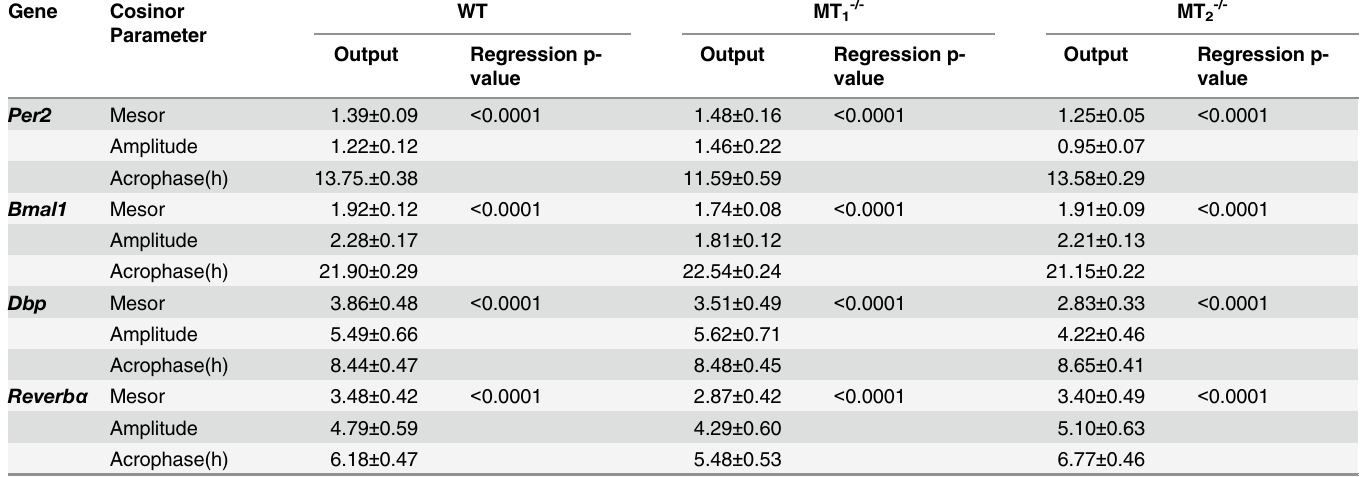
Table 4. COSINOR analysis of clock genes and clock controlled genes within the liver of WT, MT1 -/- and MT2 -/- mice. Gene Cosinor Parameter